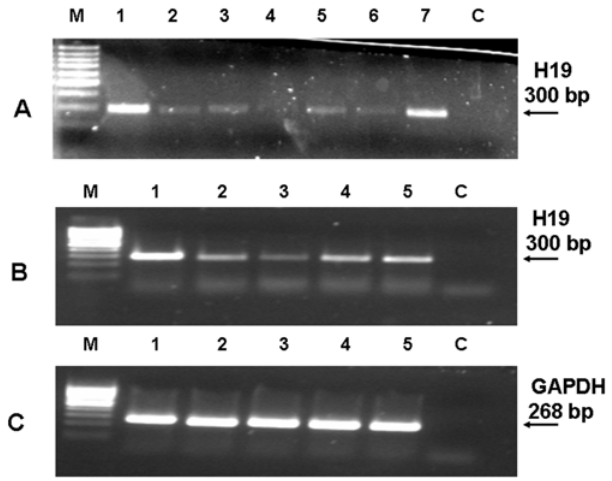
Figure 2. Effect of four different H19 siRNA duplexes on the expression level of H19 in the Hep3B cell line under normal culture condition (A) and hypoxia-mimicking CoCl2 treatment (B). Shown is H19 RNA levels (34 PCR cycles) in (A): Hep3B cells transfected with unrelated siRNA duplex that targets luciferase gene (lane 1) and with 4 different H19 siRNA1 to H19 siRNA4 duplexes (lanes 2–5) and an equimolar mixture of the four siRNAs (lane 6); for controls, we performed transfection also with lipofectamine 2000 without siRNA (Mock) (lane 7) and C is PCR blank without a target. (B): Hep3B cells were transfected under normal medium with siRNA duplex that targets the luciferase gene (lanes 1 and 5) and with 3 different H19 siRNA duplexes (lanes 2–4). Twenty four hours post transfection, media was changed, and 100 m M CoCl 2 containing media was added except for lane 5 which continued to grow under normal culture media; the incubation lasted for an additional 22 hours. (C): Shown are RT-PCR products of GAPDH gene as a positive control for RT-PCR